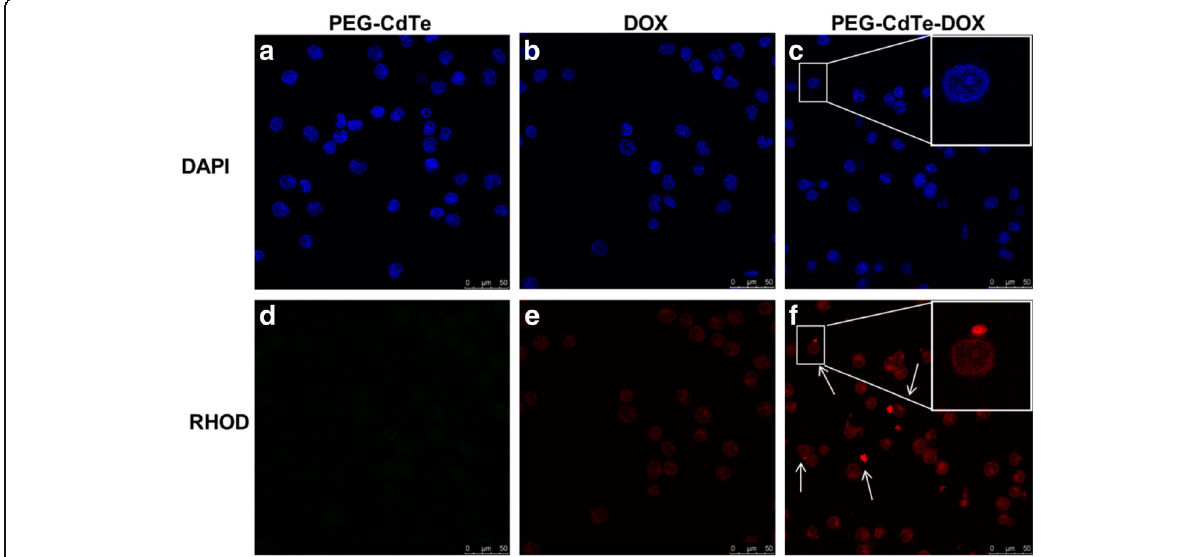
Fig. 3 Fluorescence microscopy images of PRMI 8226 cells after receiving PEG-CdTe, DOX, or PEG-CdTe-DOX. Notes: a , d PEG-CdTe; b , e DOX; c , f PEG-CdTe-DOX. The red fluorescence indicates PEG-CdTe-DOX by arrows (scale bar: 50 μ m, × 400; emission wavelengths of DAPI and DOX were 450 and 585 nm, respectively)